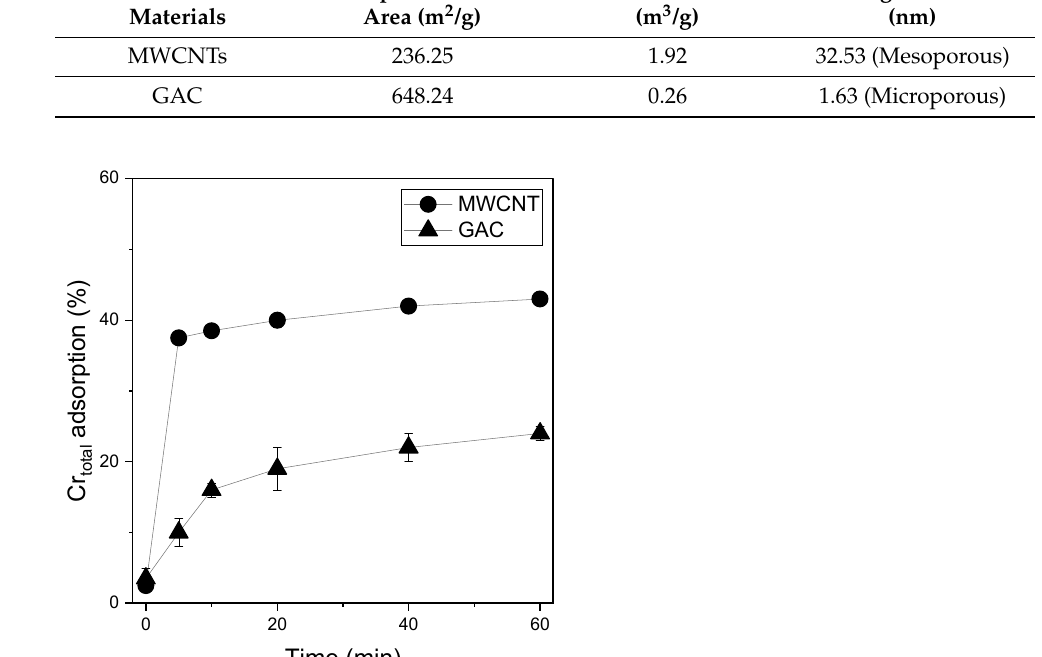
Figure 4. Adsorption of Cr total onto the surface of MWCNT and GAC, respectively, at acidic pH condition ([Cr(VI)] o = 0.1 mM, [MWCNT-Comocat] o = [GAC] o = 2.0 g/L, [pH o = 2.5], anaerobic condi- tion).